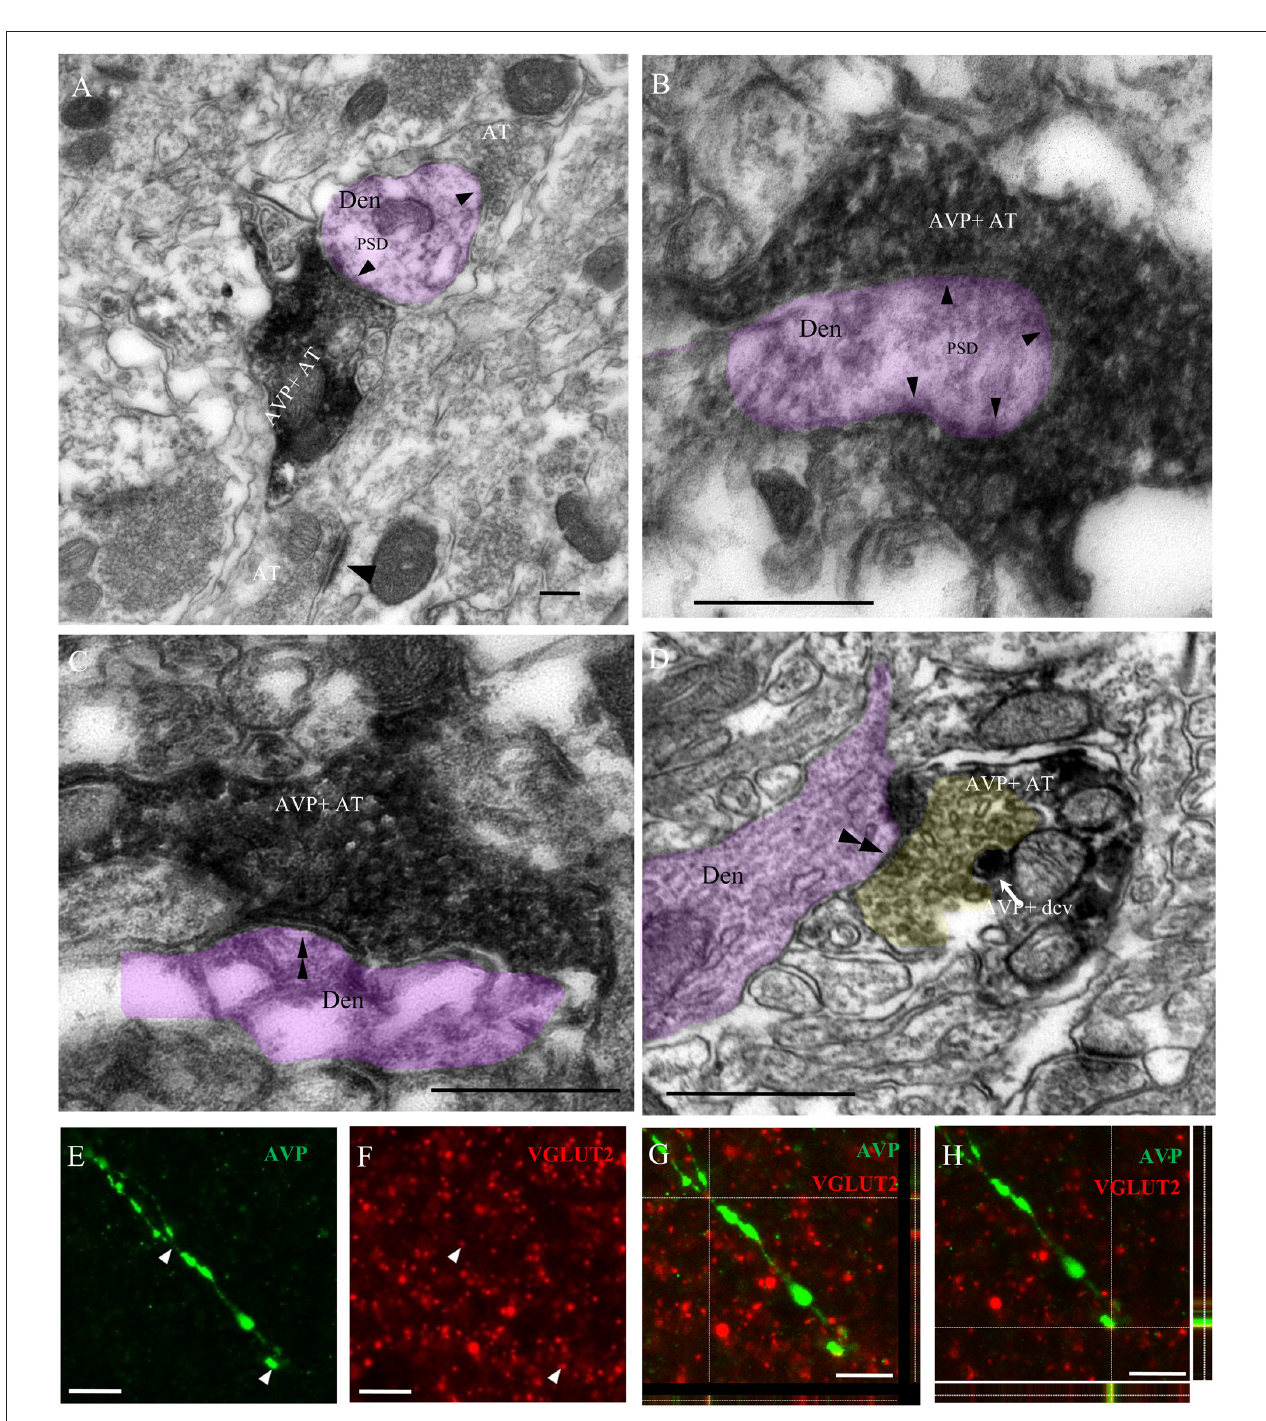
FIGURE 4 | Immuno-electron microscopical evidence of synaptic innervation by thick and thin AVP-containing fibers onto central amygdala (CeA) neurons, establishing either Gray type I (asymmetric; thick) or Gray type II (symmetric; thin) synapses. Examples of thick axon terminals (AT) (A,B) making Gray type I synapses (the presence of postsynaptic density, PSD, are indicated by single arrowheads) and thin AT (C,D) making Gray type II synapses (the absence of PSD are indicated by double arrowhead) onto CeA neurons’ dendrites (Den, pink shaded). Note that the yellow shaded presynaptic active zone of an axon terminal of a thin fiber contained pleomorphic small clear vesicles, which is a remarkable feature of a GABAergic AT; it also contained AVPir+ dense core vesicle (dcv). Thick AVPir fibers in the CeA contain vesicular glutamate transporter (VGLUT2)-positive varicosities. Confocal microscopy analysis of CeA showed thick varicose fibers immunopositive for AVP (E) and multiple VGLUT2-positive terminals (F) with co-expression of VGLUT2 and AVP in a representative thick fiber (G,H) . For (G,H) , the x–y (center), x–z (box below) and y–z (right box) images are shown. Scale bars: (A–D) 500 nm; (E–H) 10 µ m.